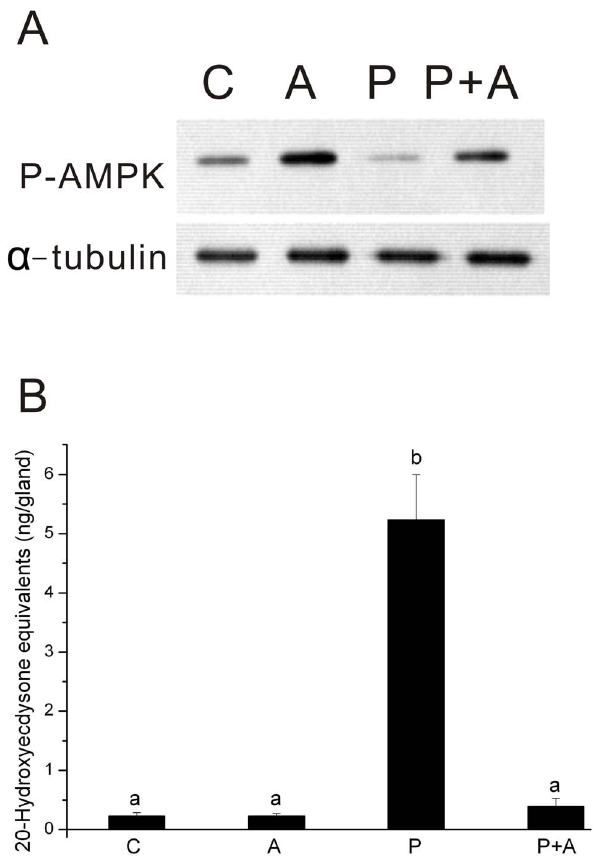
Figure 7. Effects of AICAR on PTTH-regulated AMPK phos- phorylation (A) and ecdysteroidogenesis (B). C, glands incubated in control medium; P, glands incubated in medium containing PTTH only; A, glands incubated in medium containing 1 mM AICAR only; P + A, glands incubated in medium containing both PTTH and AICAR. Results shown for the Western blot analysis are representative of three independent experiments. Each bar represents the mean 6 SEM ( N =8). Different letters above the bars indicate a significant difference (ANOVA followed by Tukey’s multiple-comparisons test, p , 0.01).